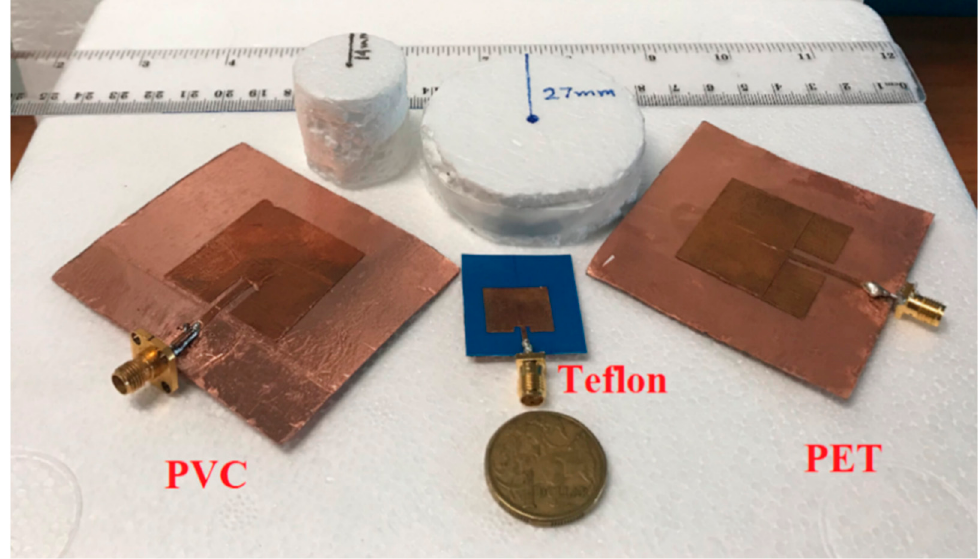
Figure 7. Actual aspects of fabricated E-Shaped microstrip antennas operating at 2.45 GHz on substrates PVC ( left ), Teflon (Centre), and PET ( right ).